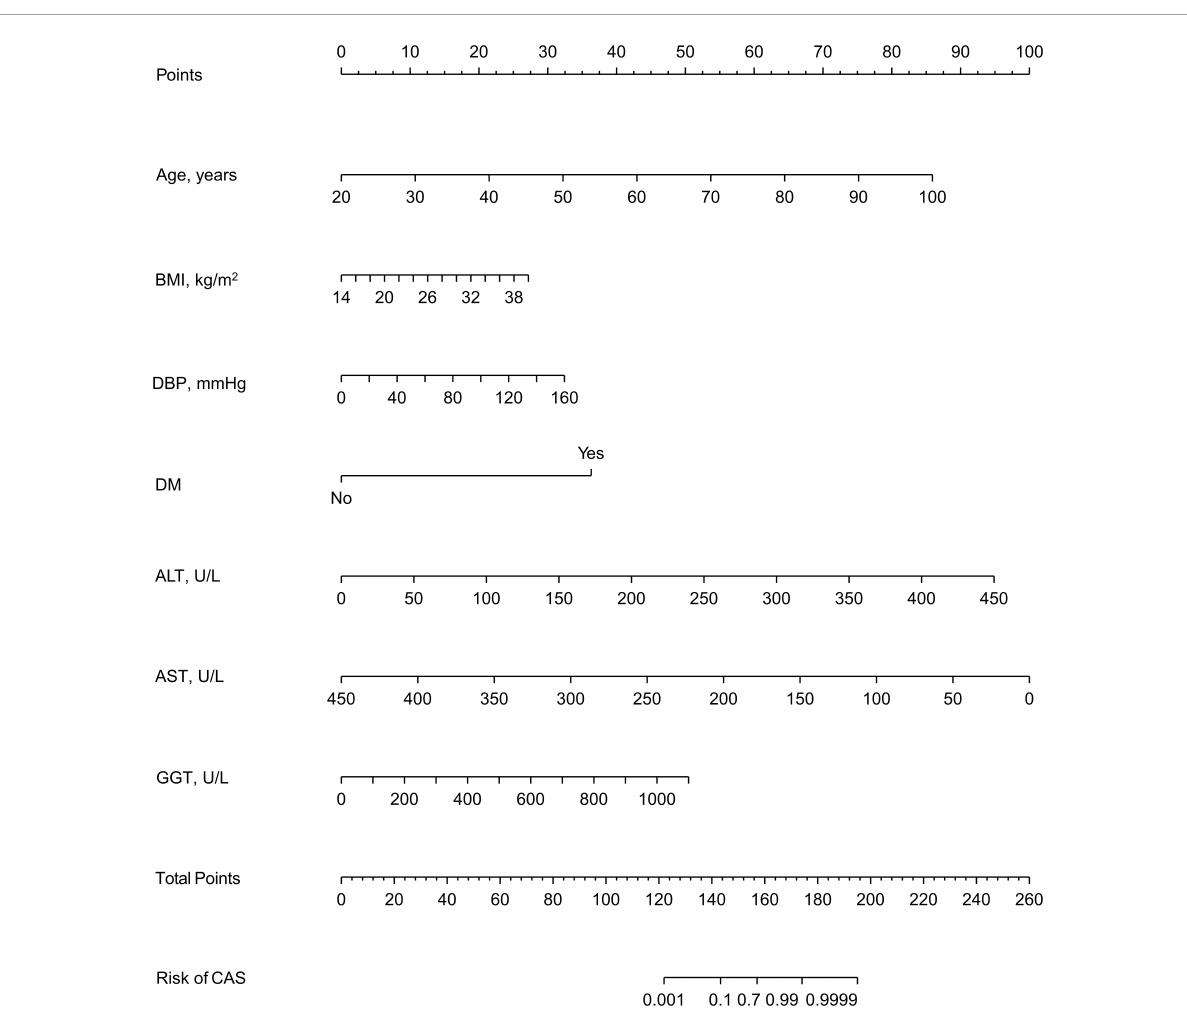
FIGURE3 A nomogram for predicting the probability of the development of CAS. The nomogram is used by scoring each variable on its corresponding score scale. The scores for all variables are then summed up to obtain the total score, and a vertical line is drawn from the total point row to indicate the estimated probability of the development of CAS. carotid atherosclerosis, CAS; body mass index, BMI; systolic blood pressure, SBP; diastolic blood pressure, DBP; diabetes mellitus, DM; alanine aminotransferase, ALT; aspartate aminotransferase, AST; gamma-glutamyl transpeptidase,